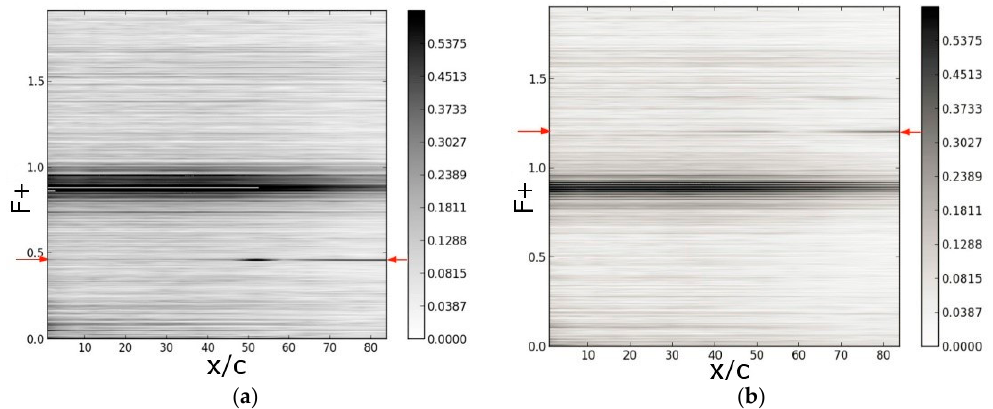
Figure 39. Wing glove wind tunnel measurements for Re = 280,000 and α = 8 degrees. Temporal Fourier transforms of wall pressure coefficient versus chord length. Active flow control with B = 0.81 and ( a ) F + = 0.46 and ( b ) F + = 1.2. (Reprinted by permission of the American Institute of Aeronautics and Astronautics, Inc. (Reston, VA, USA) from [37]).